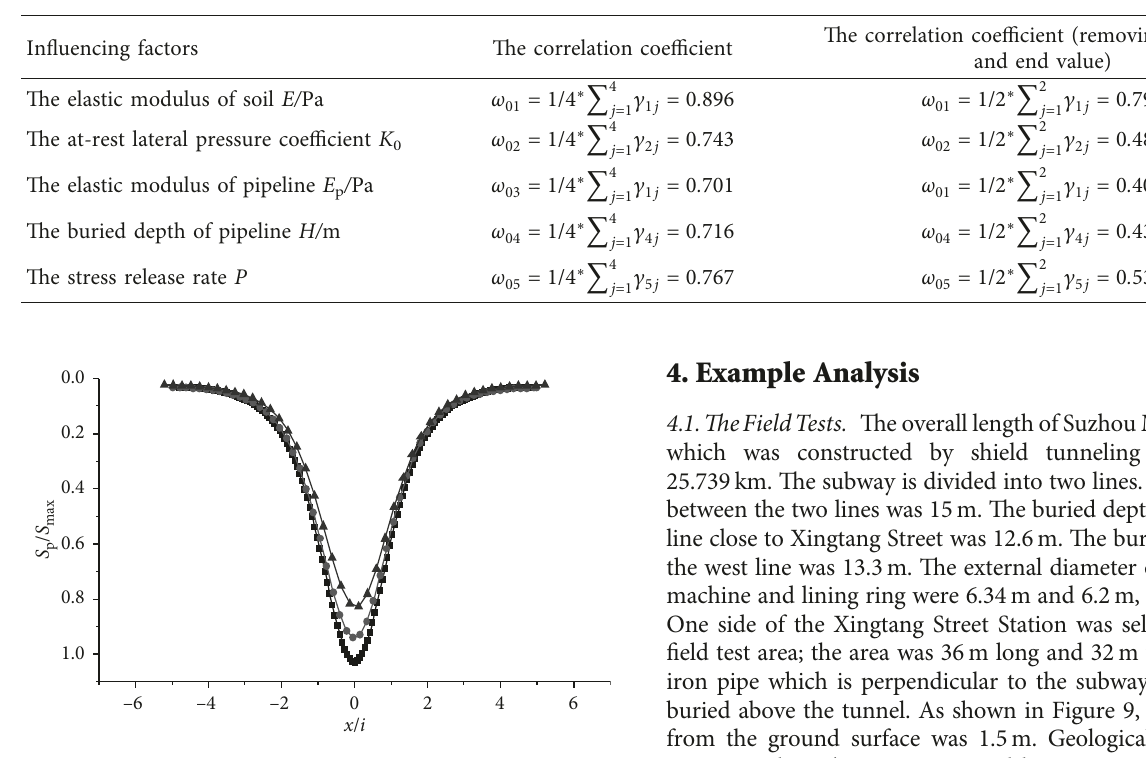
Table 1: Correlation calculation table.